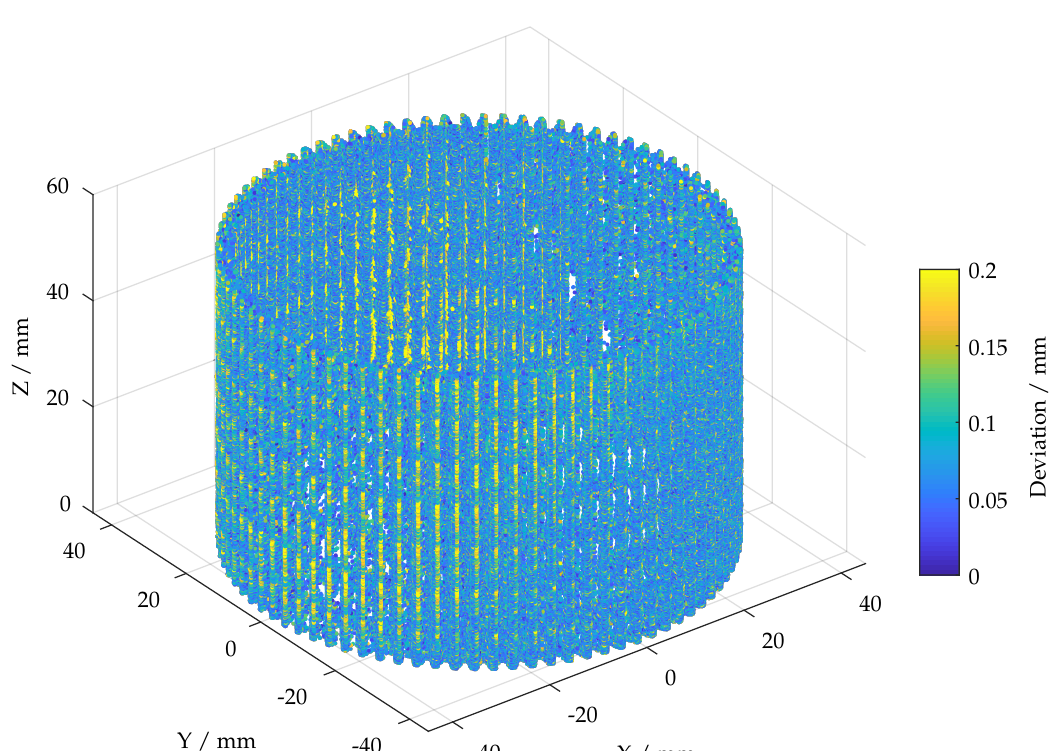
Figure 20. Calculated deviations projected onto a cylinder.